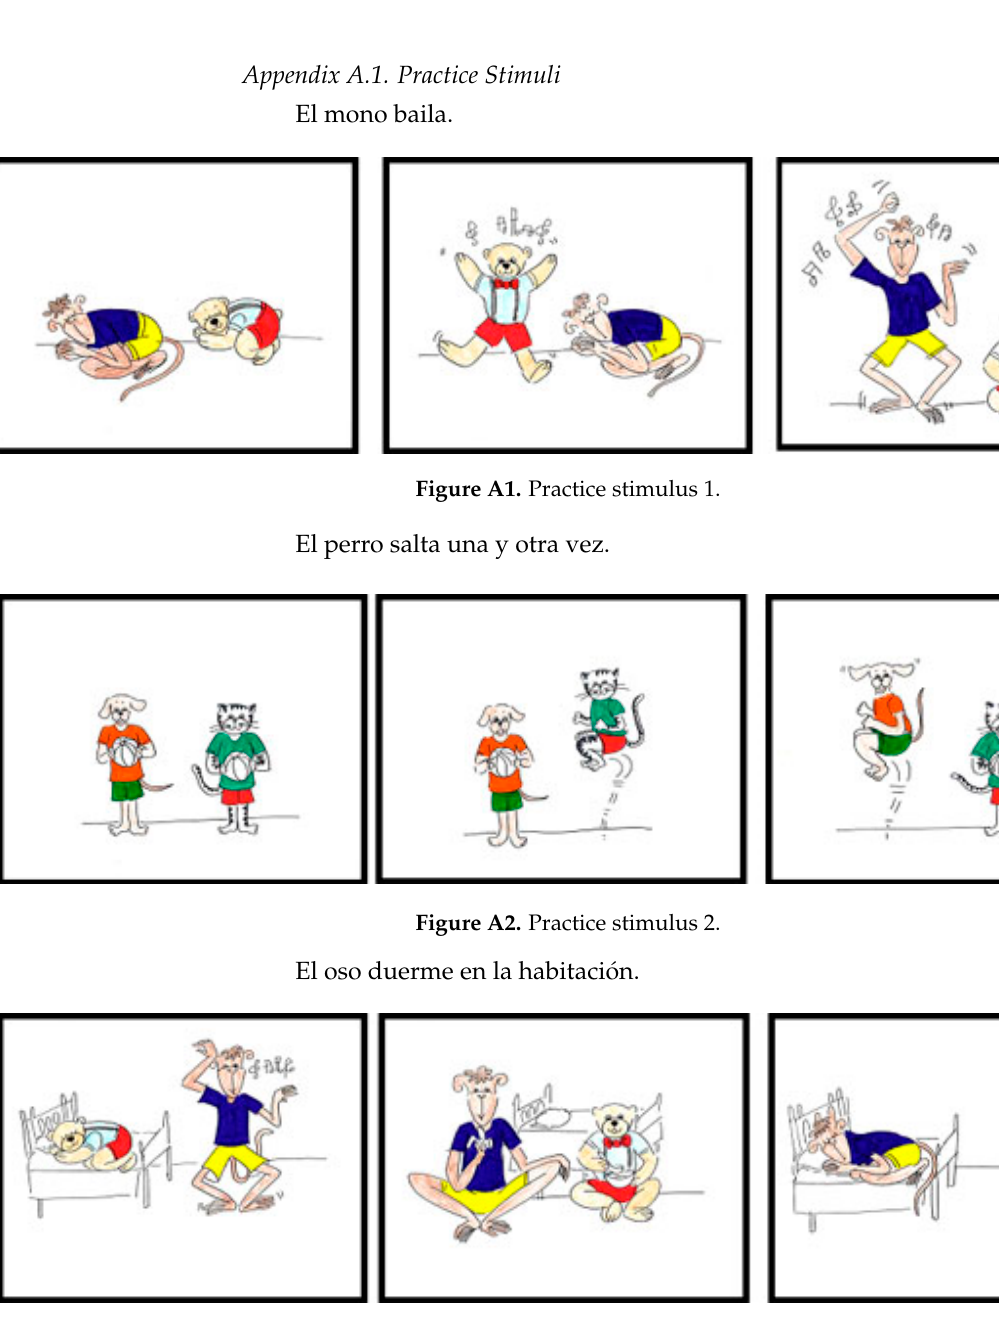
Figure A3. Practice stimulus 3. El gato corre hacia la acera con el conejo.